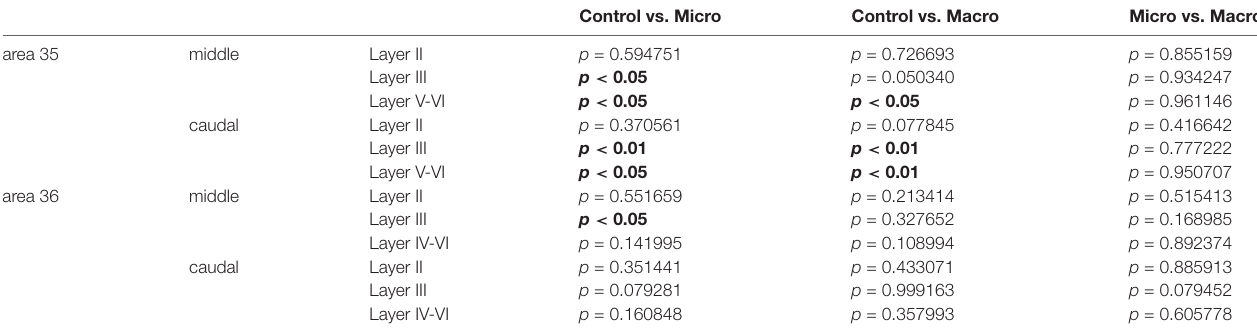
TABLE 4 | The outcome of post hoc analyses (Fisher’s LSD test) to assess differences between the three groups (control, micro, and macro) of each layer of each compartment of areas 35 and 36. Control vs. Micro Control vs. Macro Micro vs.